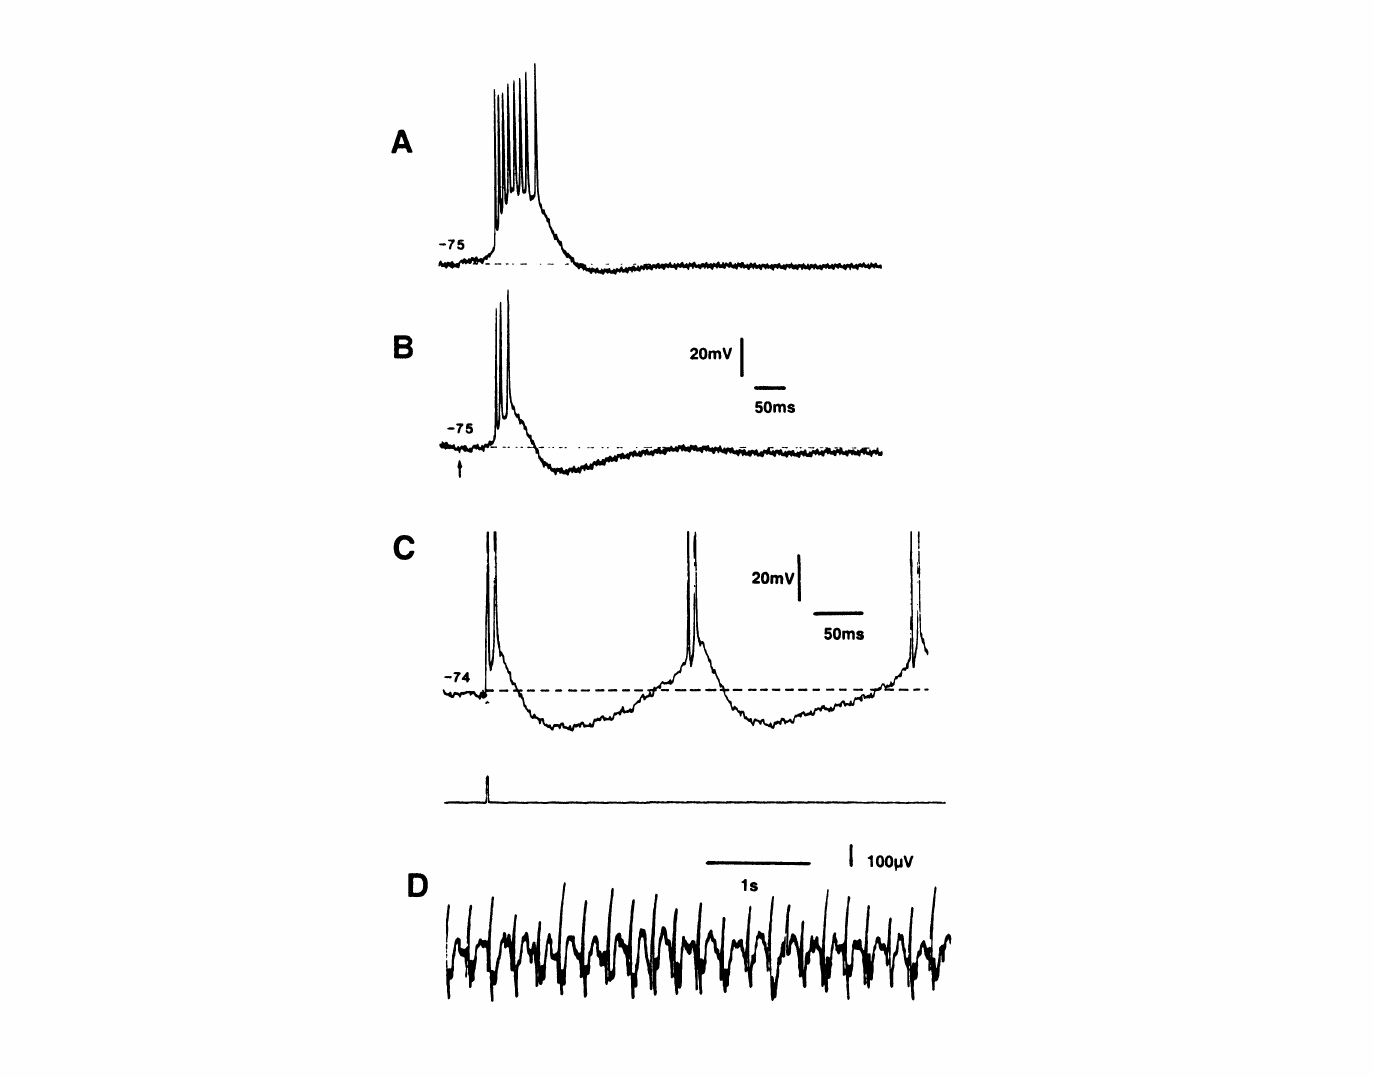
Fig. 6: Effects of norepinephrine on paroxysmal depolarization shitts recorded in a bursting cell. A and B: paroxysmal depolarization shifts recorded in a bursting cell before and atter norepinephrine application, respectively, at the same resting membrane potential. Norepinephrine provoked a decrease in paroxysmal depolarization shift amplitude and duration, a decrease in the number of Aps, and an increase in the afterhyperpolarization amplitude. C: Effects of norepinephrine on burst frequency: Note that the shortening of paroxysmal depolarization shifts and the increase in afterhyperpolarizations facilitates the appearance of extraburst during norepinephrine application and determines their frequency. D: Electroencephalographic spikes observed in living animals; Note that their frequency corresponds to the frequency of paroxysmal depolarization shifts, namely, 5 Hz during the peak of the norepinephrine-induced